Question: In a single sentence, describe what this figure presents.
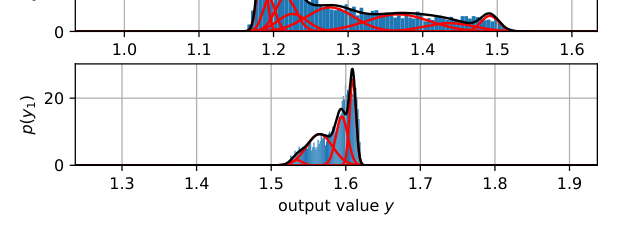
Answer: Probability density histograms of the system output under different noise realizations compared with the pre- dicted output distribution of the meta-state-space model. Since the model output distribution is parameterized as a weighted sum of normal distributions, these weighted com- ponents are also displayed.